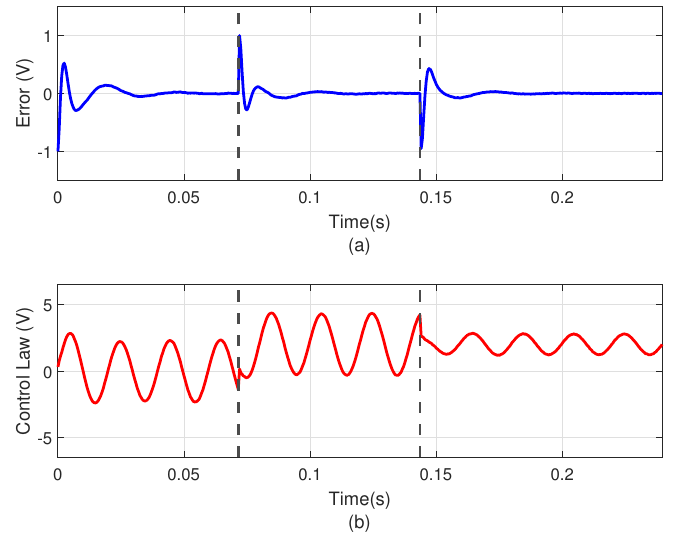
Figure 5. Experimental result for test 1, using p = 20, c = 1, r u = 0.07. ( a ) Error. ( b ) Control